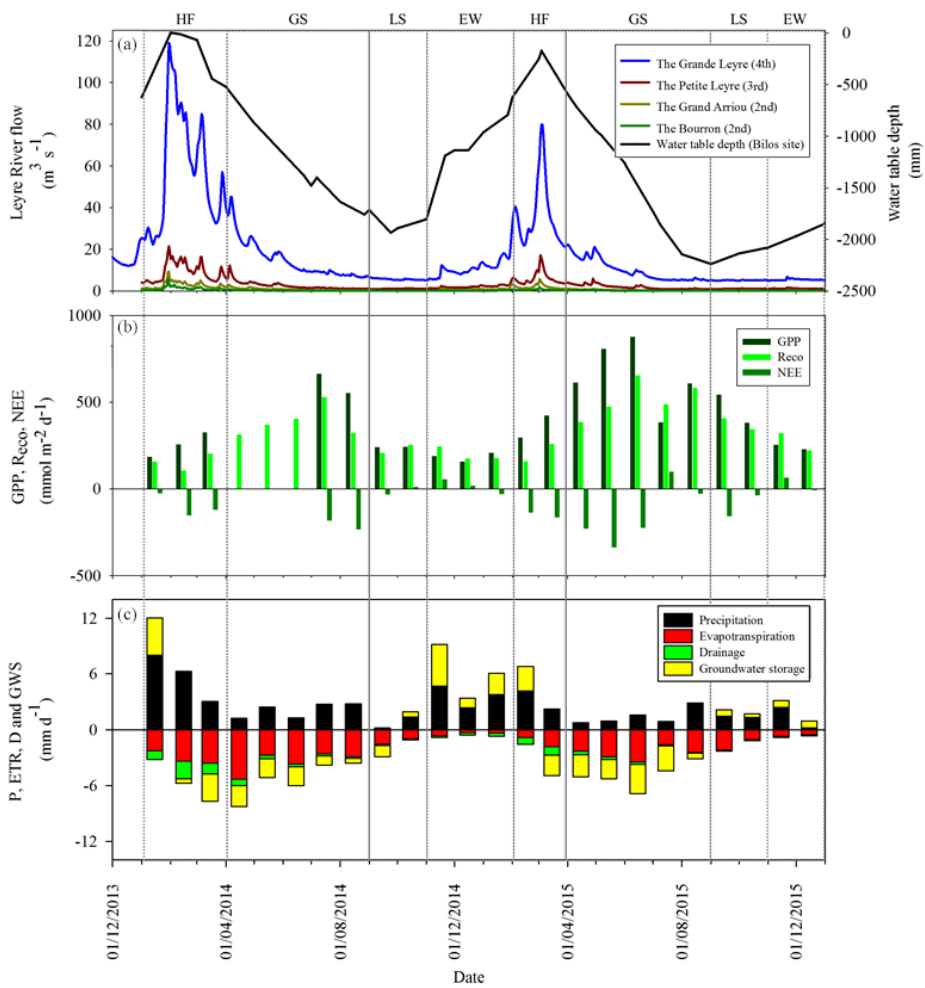
Figure 2. Seasonal variations in hydrological parameters in the Leyre watershed. (a) Discharge of the Grande Leyre, the Petite Leyre, the Grand Arriou and the Bourron rivers associated with water table at the Bilos site. (b) Metabolic parameters (NEE, GPP, R eco ) estimated at the Bilos site. (c) Monthly precipitation, evapotranspiration and groundwater storage at the Bilos site as well as the drainage of first-order streams. Inputs of water (precipitation and positive groundwater storage) in the studied ecosystem are represented on a positive scale whereas outputs of water (drainage, evapotranspiration and negative groundwater storage) are represented on a negative scale. HF, GS, LS and EW represent